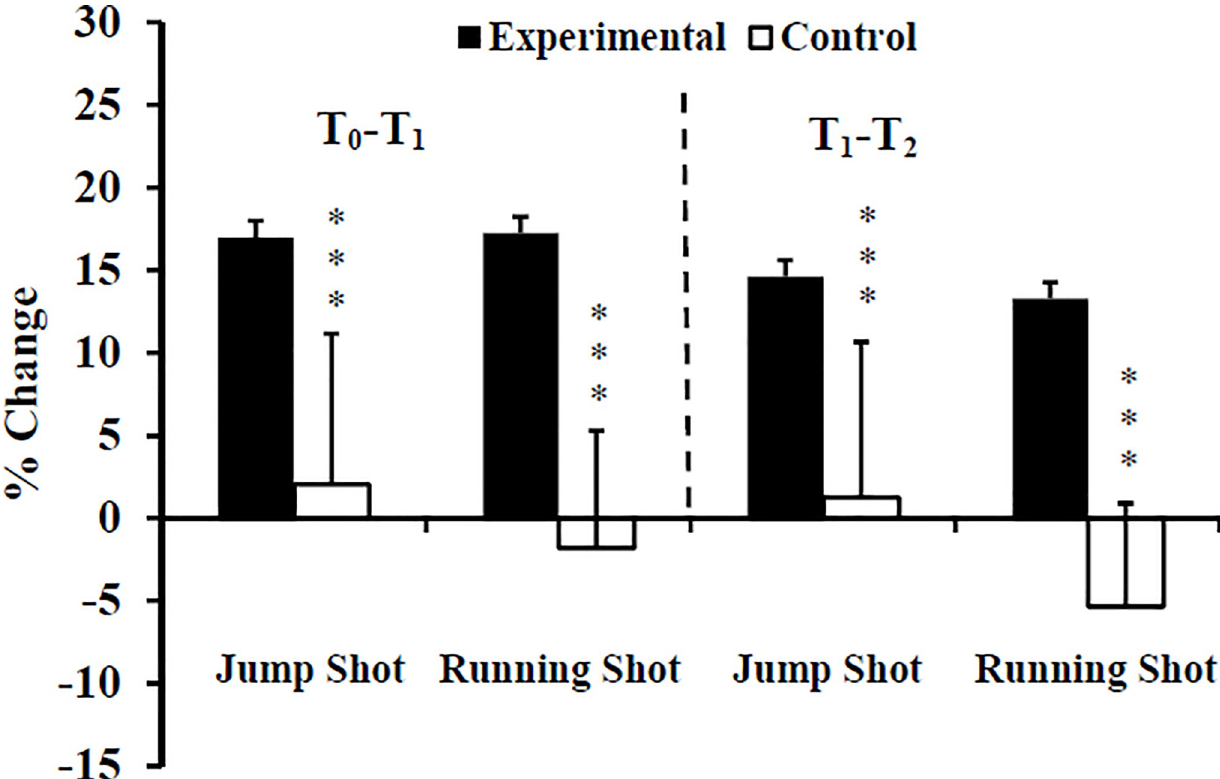
Fig 5. Percentage change of ball throwing velocity at T1, and T2 for Experimental (E) and Control (C) groups. T 0 : before training; T 1 : after 10 weeks of resistance training; T 2 : after 2 weeks of tapering; ��� : ANOVA group x time interaction significantly different between E and C at the level of p < 0.001.